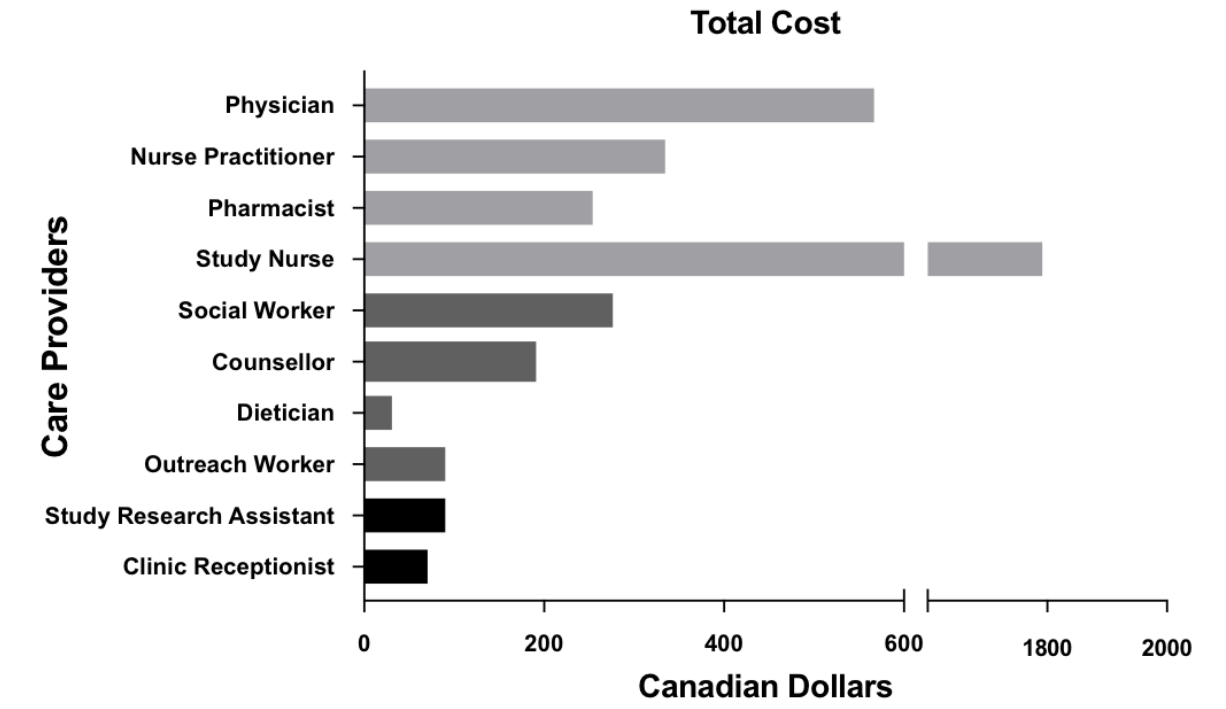
Figure 7. Total cost per health care provider over study